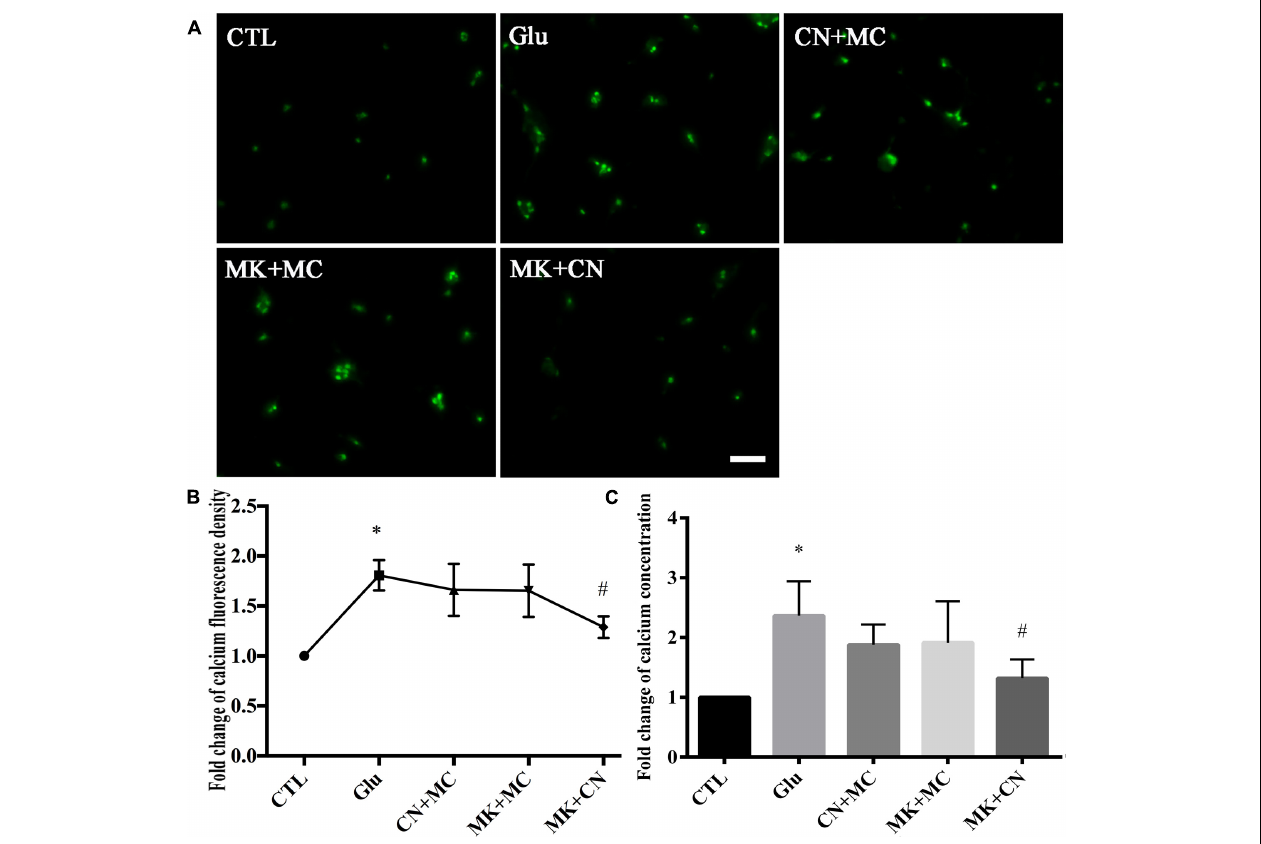
FIGURE 2 | Calcium concentrations in retinal neuron cultures after different GluRs inhibition. (A) Calcium concentrations indicated by Fluo-4 signals. (B) Quantitative analysis of Fluo-4 signals intensity. (C) The fold change of calcium concentrations was determined by cell calcium assay commercial kit. MK, CN, and MC, which respectively block NMDAR, AMPA/KA receptor and mGluRs, were added to the cultures at a final concentration of 10, 10, and 50 µ M, 30 min before 15 min glutamate insult. Experiments were repeated three times. Data were analyzed using one-way ANOVA. ∗ p < 0.05 vs. CTL group, # p < 0.05 vs. Glu group. Scale bar = 20 µ m in all panels.